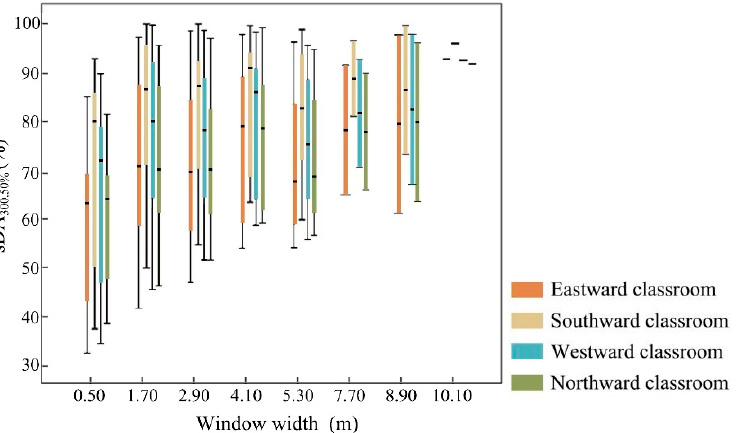
Figure 8. The analysis results of the distribution interval between the window width and the evaluation index.